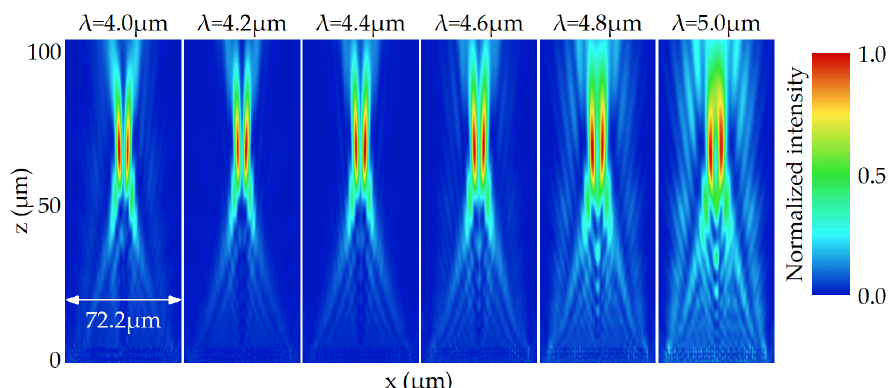
Figure 4. The simulated electric field intensity on the x-z plane for the FVBG with zero dispersion between 4.0 and 5.0 μ m.